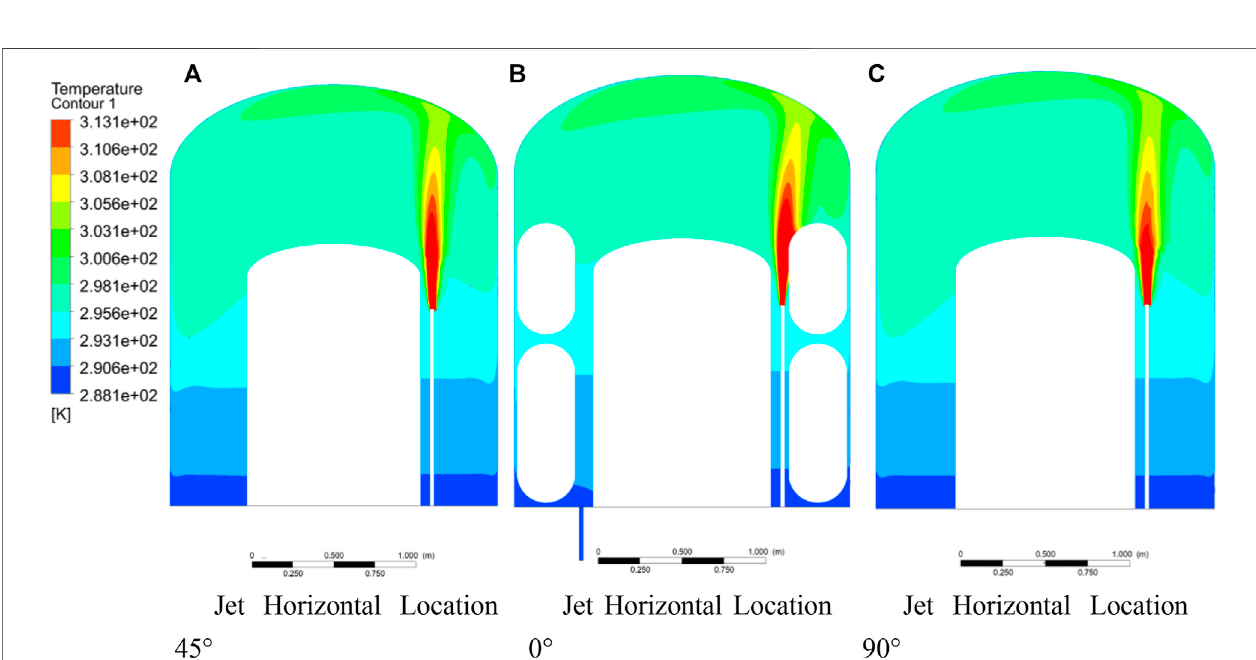
FIGURE 10 | Temperature fi led of the containment at different jet positions. (A) Jet horizontal location 45 ° . (B) Jet horizontal location 0 ° . (C) Jet horizontal location 90 ° .